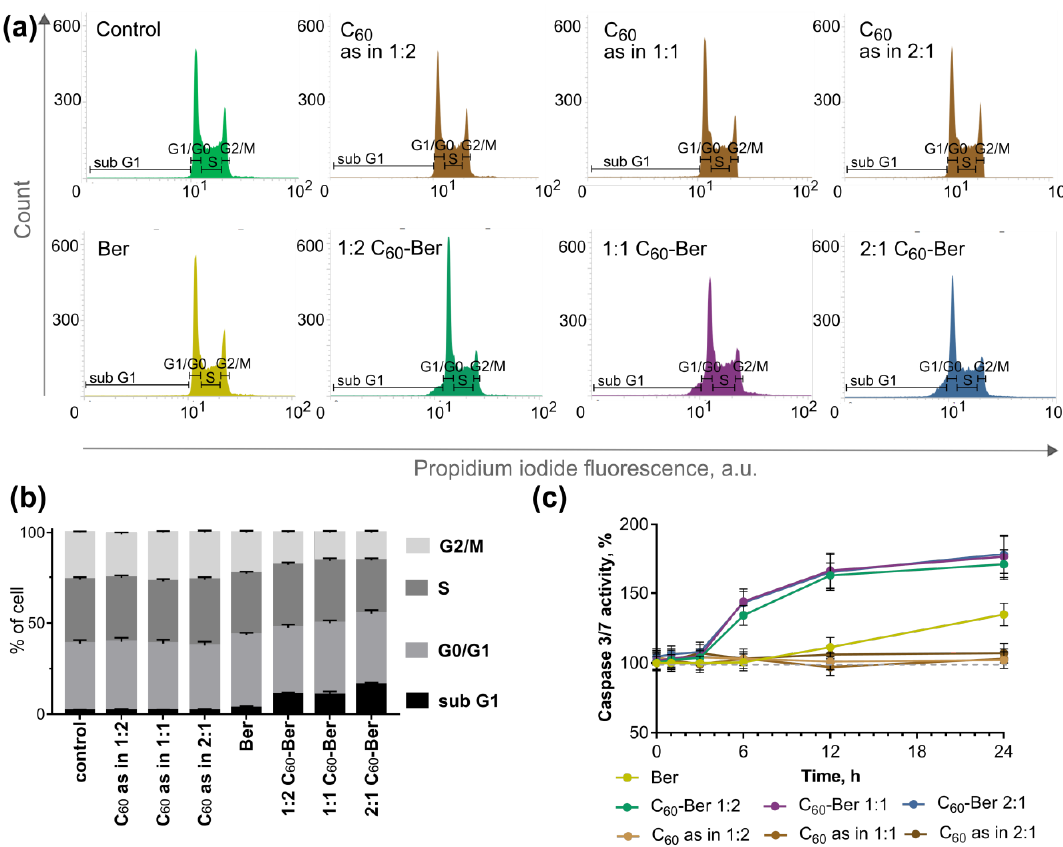
Figure 10. Apoptosis induction: cell cycle analysis in CCRF-CEM cells, incubated for 24 h after treatment with and without free C 60 , Ber or C 60 -Ber nanocomplexes at 10 µ M Ber equivalent concentration presented with flow cytometry histograms ( a ) and a bar graph ( b ), which depicts the mean percentage of each cell cycle phase; caspase 3 / 7 activity in CCRF-CEM cells ( c ), incubated for 24 h after treatment with either free C 60 , Ber, or C 60 -Ber nanocomplexes at 10 µ M Ber equivalent concentration (caspase 3 / 7 activity of untreated cells is set to 100%).